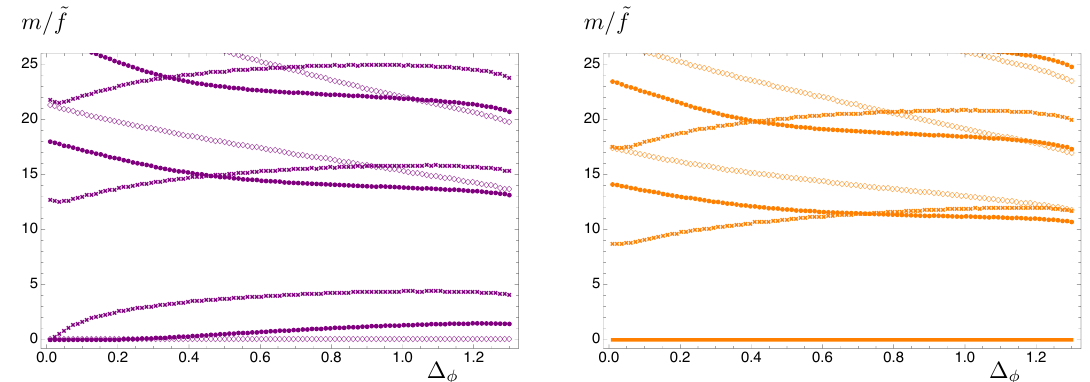
Figure 7 . Model II. Fermionic spectrum as a function of ∆ φ for ∆ R = 1 . 51 , 2 . 5 , 4 (diamonds, dots, crosses), ∆ = 3 , x F = 1 , g 5 = 8 , y 5 = − 2 , φ c = 1 . 5 , r 1 = 10 − 12 , r 2 = 15 . The left and right panels correspond to imposing (+) and ( − ) IR boundary conditions, respectively. All plots are normalised to the decay constant ˜ f . The solid line in the right panel indicates the presence of a massless